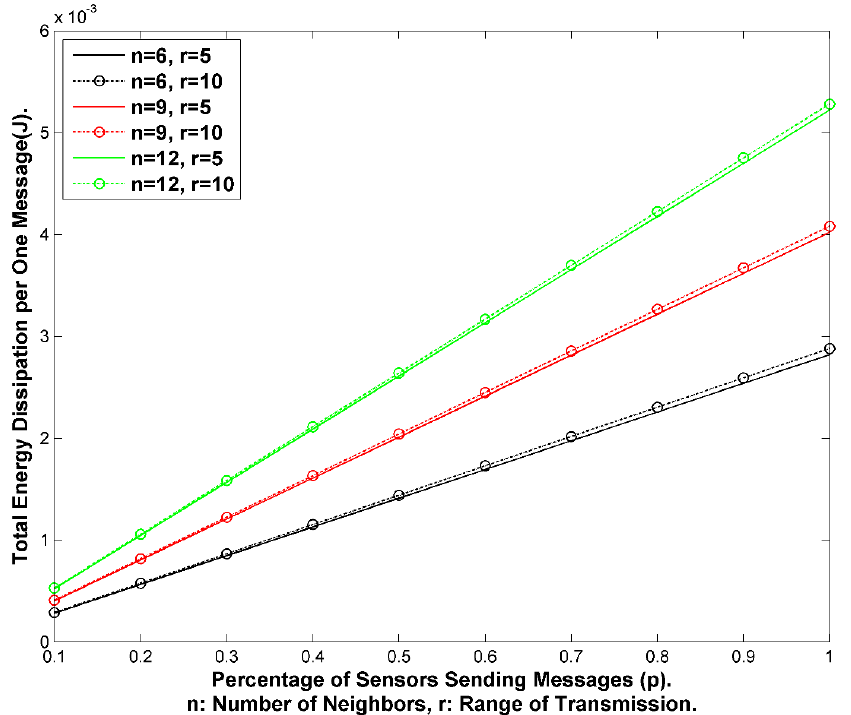
Figure 24. The energy dissipation increases as the number of neighbors and the sensor transmission range increases. Simulation assumed message size of 8000 bits, Ԑ is 50 nJ/bit and ԑ is 100 pJ/bit/m 2 .